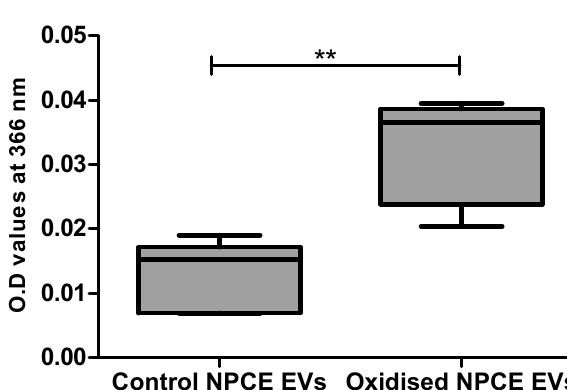
Figure 2. Carbonylated protein presence in oxidized NPCE-derived EVs. Carbonylated proteins in control and oxidized NPCE cells (15 mM AAPH, 90 min) derived EVs were measured at 366 nm using the DNPH method. 1.28 × 10 11 particle/mL equal to 0.30 mg proteins/mL were used. Data are represented by mean ± SD. Comparisons were performed by two tails t-test, and any difference in comparison were significant with ** p < 0.01.